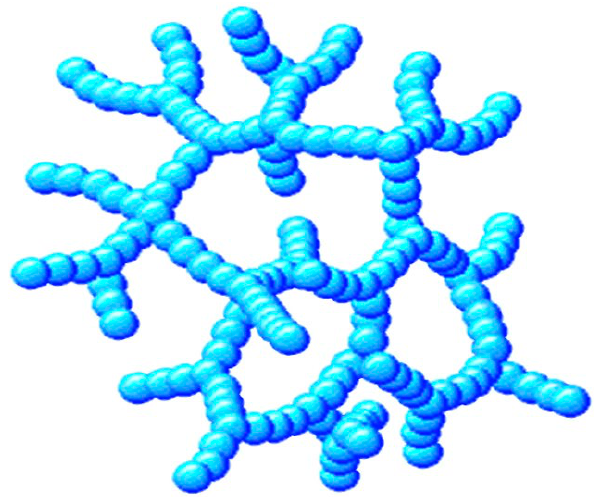
Figure 51. In natural silica gels the density and structure vary by a number of different kinds of packing in the meshwork arrangement of the particle chains. In a more open regular meshwork such as that illustrated here, the number of particles linked to a given particle can vary. In this example each joining sphere is touched by 3 or 4 surrounding spheres but denser linking arrangements are